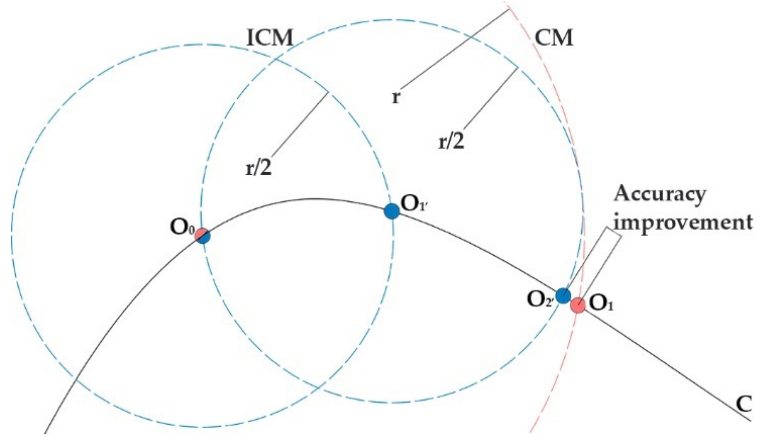
Figure 10. Improved Compass Method versus Compass Method.